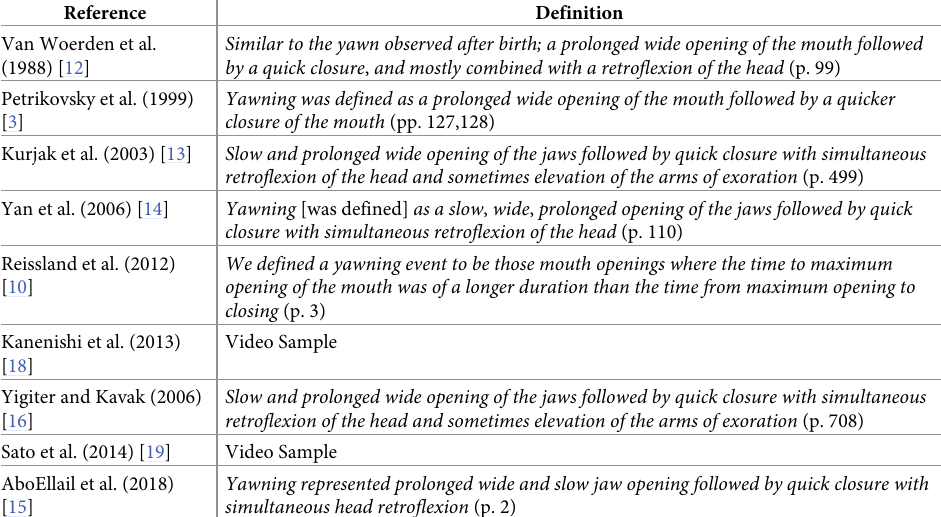
Table 2. Operational definitions of fetal